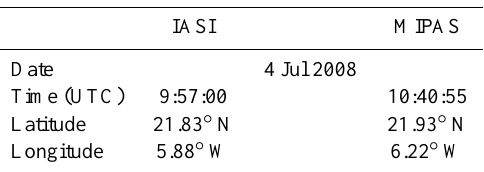
Fig. 7. Number of degrees of freedom as a function of the number of components used to represent the MSS in the simulated case for the profiles retrieved using only the IASI measurement (green line), only the MIPAS measurement (blue line) and the IASI-MIPAS data fusion (black line). The dashed red line corresponds to the ideal case that each measured component contributes with one degree of freedom. Table 2. Geolocations of the IASI and MIPAS measurements that have been fused.